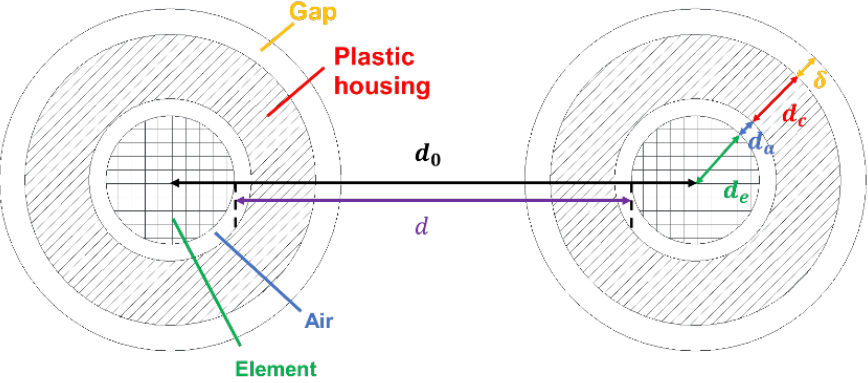
Figure 4. Cross-sectional view of the probe.